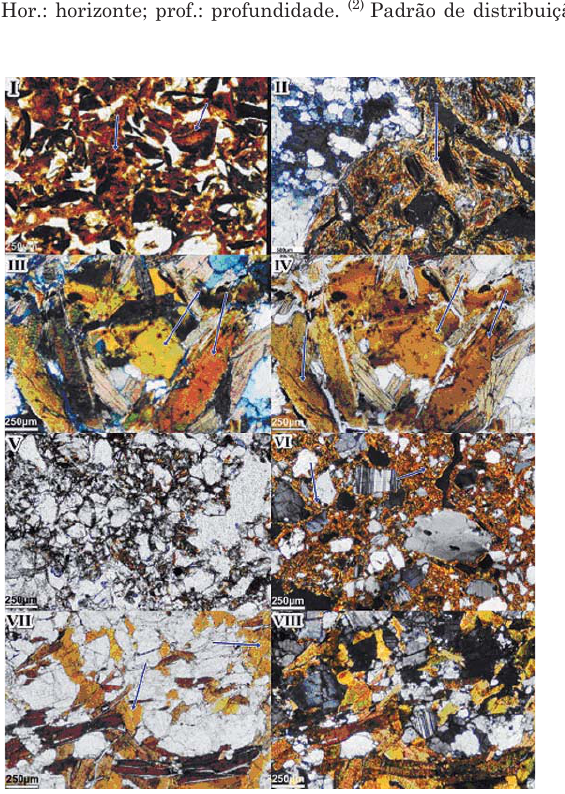
Figura 3. Fotomicrografias mostrando: argilificação nos horizontes Bt e C do perfil 7 (I e II), na camada R do perfil 8 (III e IV) e no horizonte Cr do perfil 9 (VII e VIII); desargilização do horizonte E (V); e PDR porfírico com contextura-b granoestriada do perfil 9 (VI).